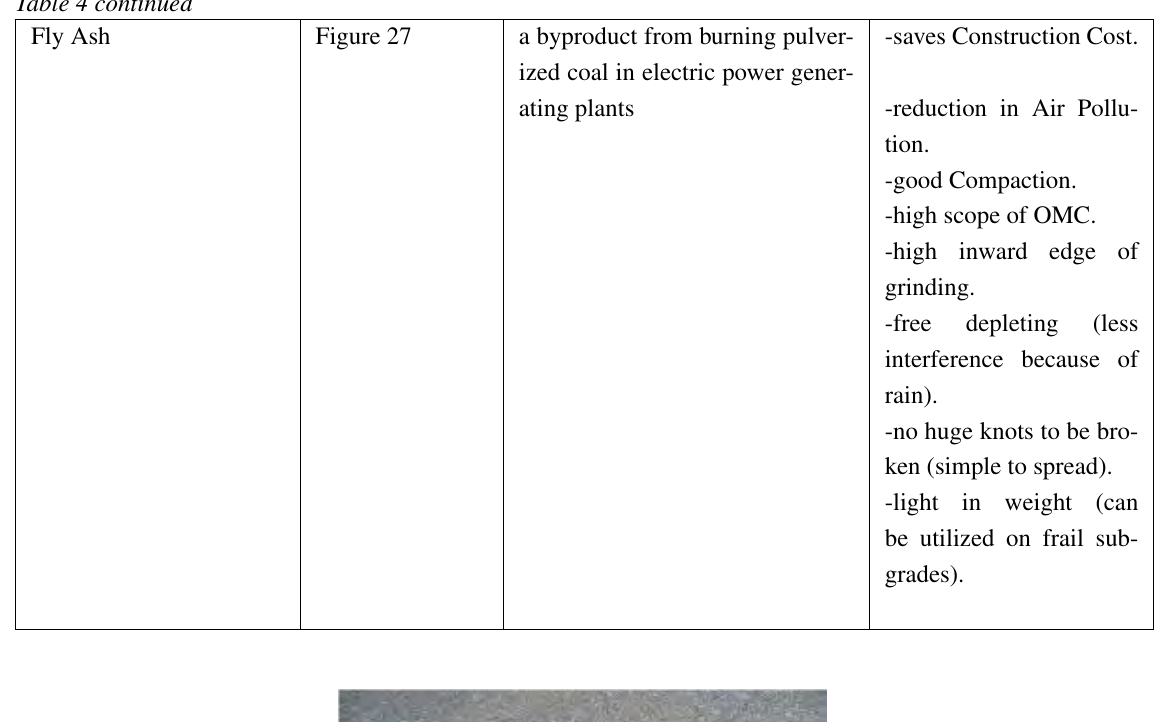
-saves Construction